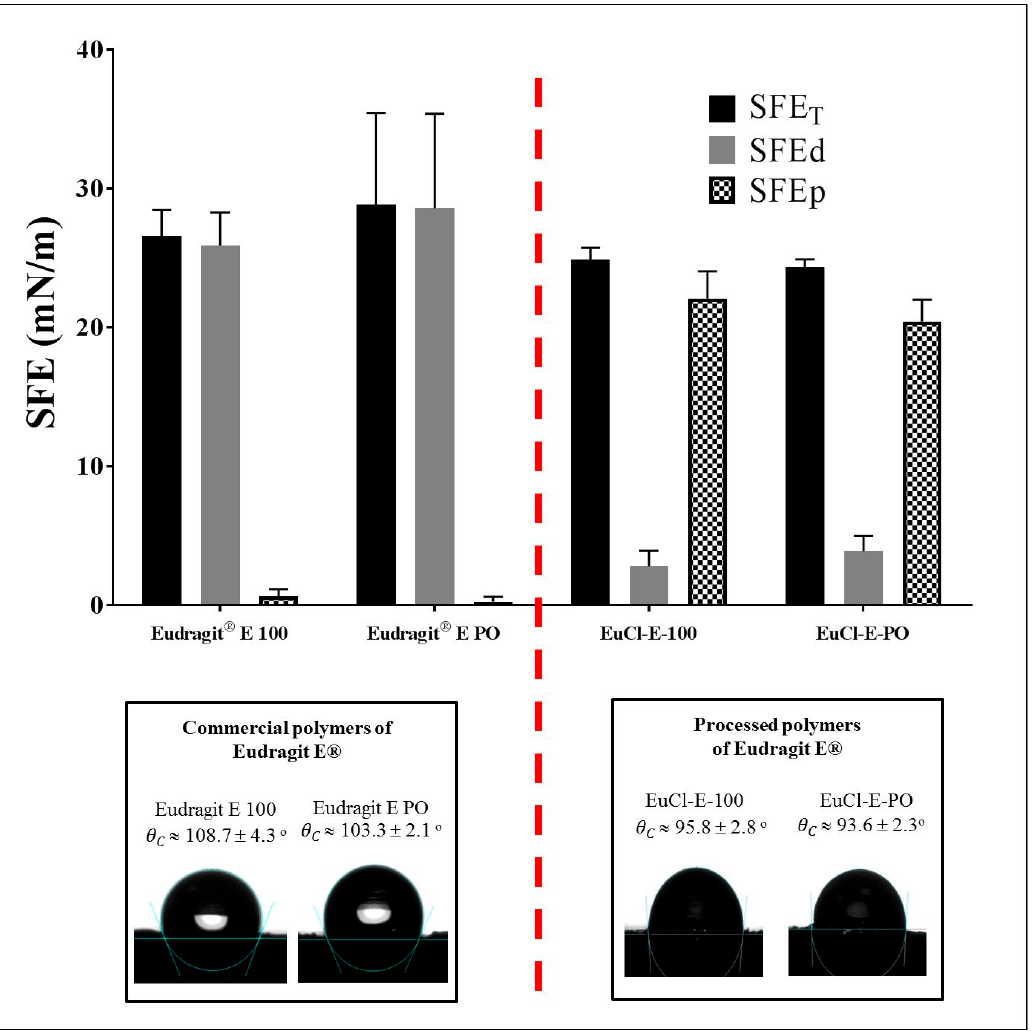
Figure 8. Variation in surface free energy and contact angle between ultra-pure water and the polymers derived from Eudragit E-100.